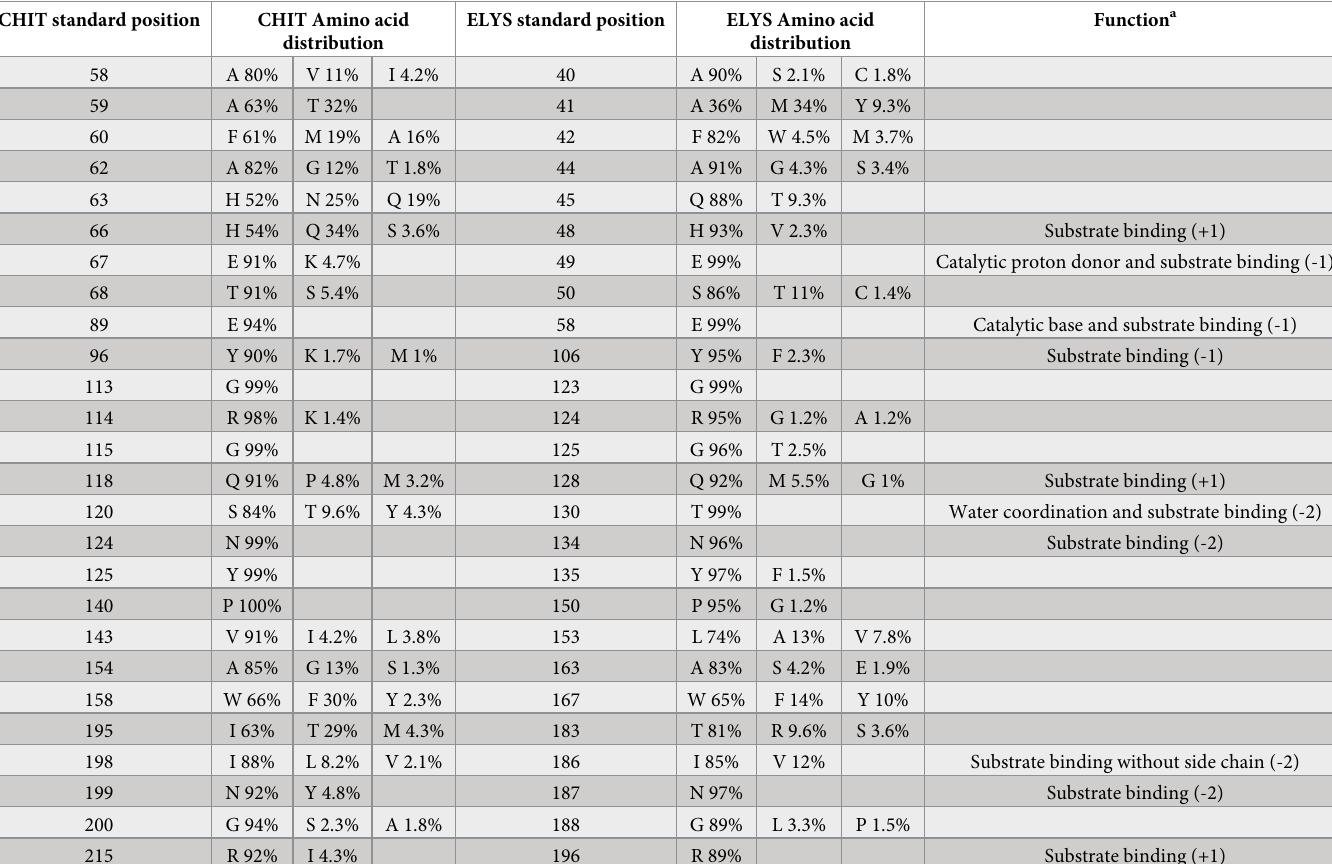
Table 1. Conserved core shared in CHIT and ELYS subfamilies. Structurally aligned positions are listed in each row, numbered according to each subfamily-specific standard numbering scheme (see Methods section). Information is provided about the percentage of conserved residues if higher than 5%. CHIT standard position